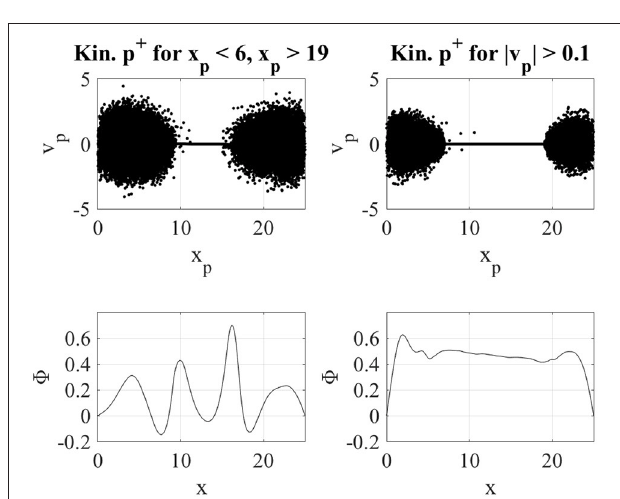
The electric field at the particle position is calculated from the values of the electric field defined on the grid using the interpolation function as E n